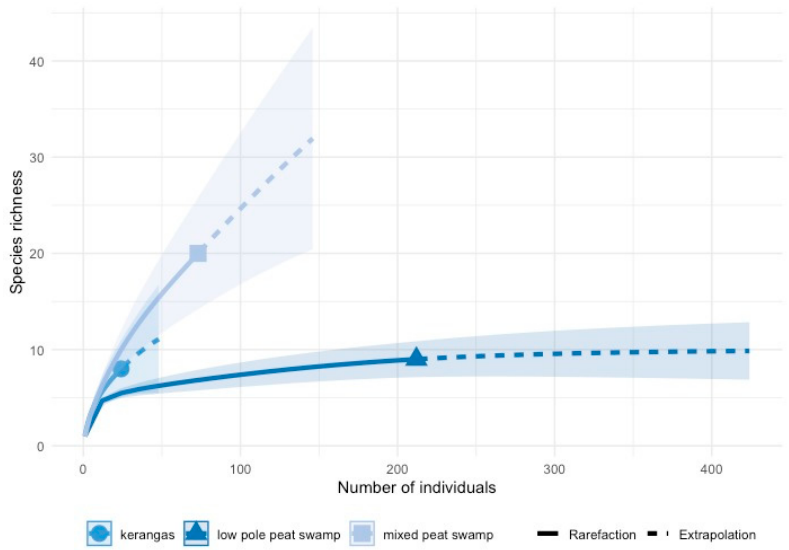
Figure 3. Species accumulation curve of Odonata (dragonflies and damselflies) for the three studied habitat types: mixed peat swamp, kerangas (heath), and low pole peat swamp. The solid line represents observed values while the dotted line presents extrapolated estimates of species richness with continued sampling.